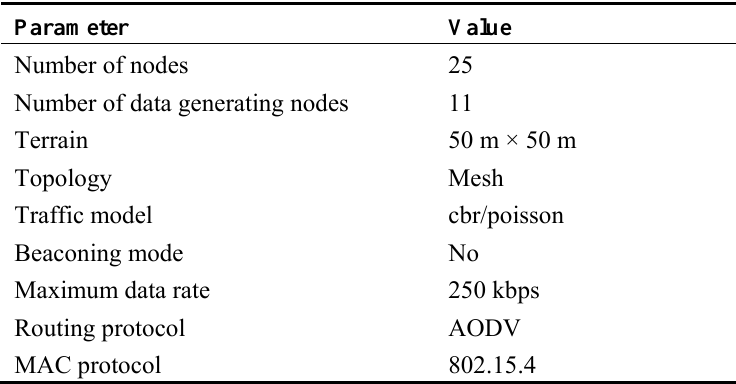
Table 3. Simulation Parameters of